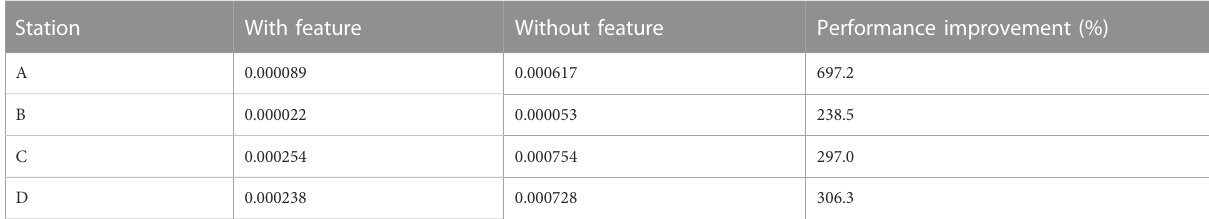
TABLE 4 Comparison of results of methods with and without